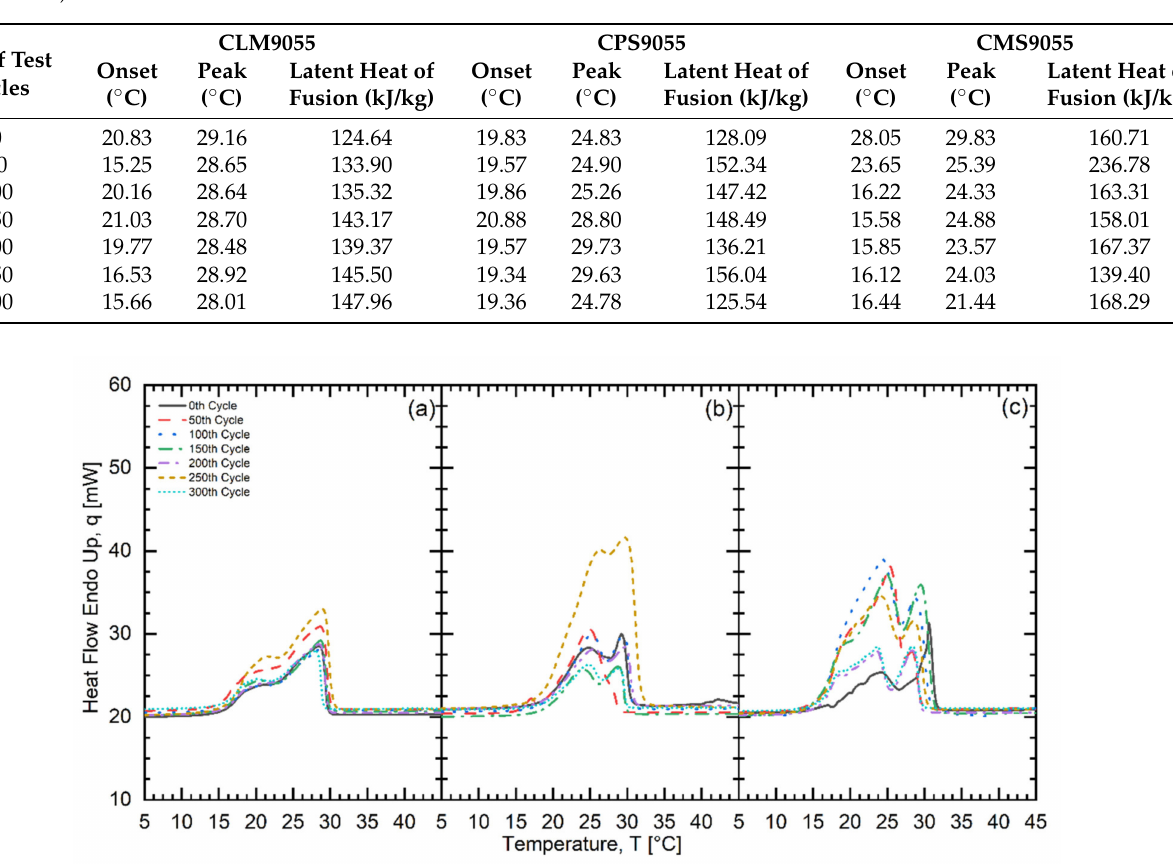
Figure 11. Cycle testing ( a ) CLM9055 ( b ) CPS9055 ( c ) CMS9055.